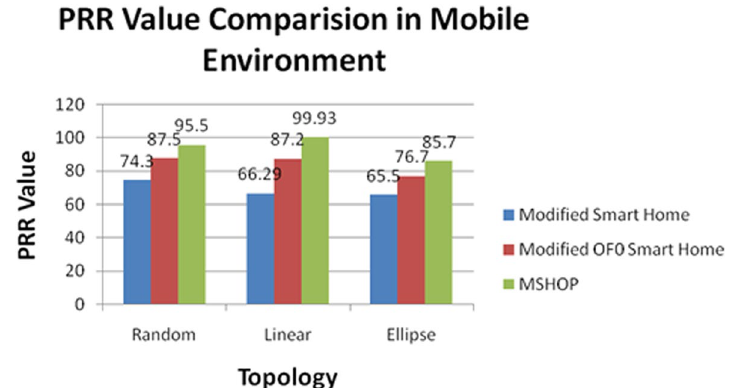
Fig. 22 PRR compared between MSH with MRHOF, MSH with OF0, and MSHOP in mobile